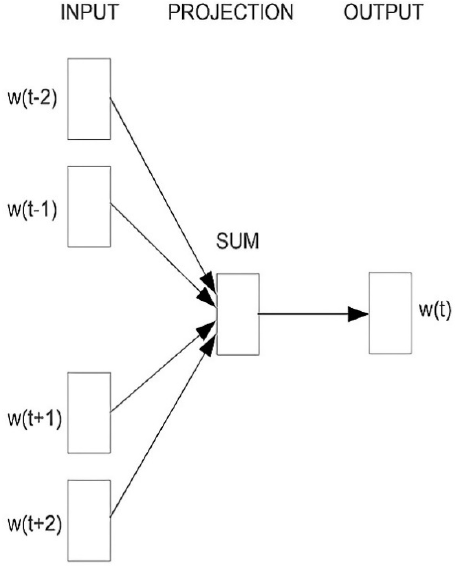
Figure 2. Current target word predicted by continuous bag of words (CBOW).